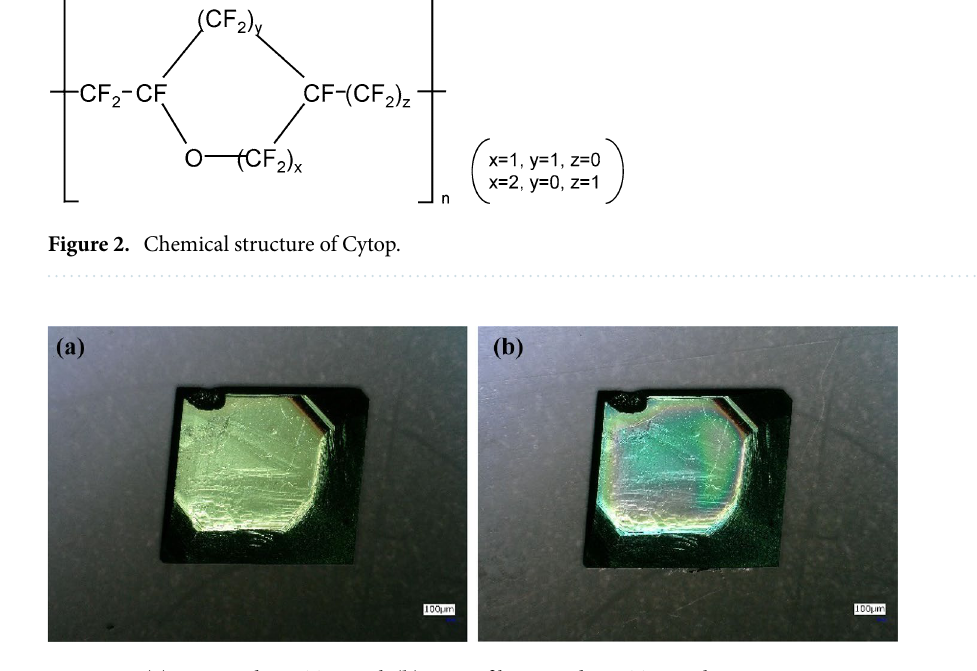
Figure 3. ( a ) Uncoated DAST crystal, ( b ) Cytop film coated DAST crystal.